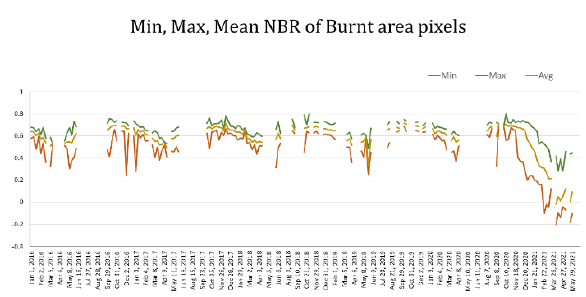
Figure 9: Min, Max, and Mean NBR of the burnt area points taken from Google earth pro in the Mizoram